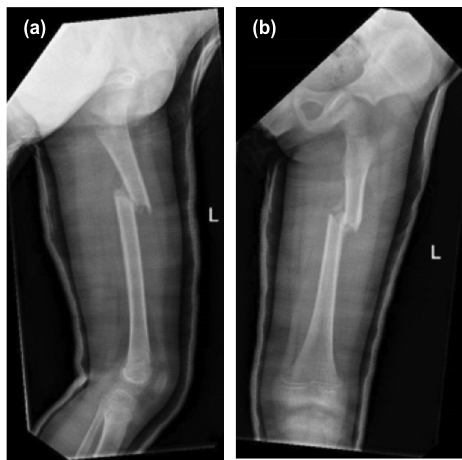
(a,b) Radiographs for the final shortening of patient B showing instability of the Fig. 4: